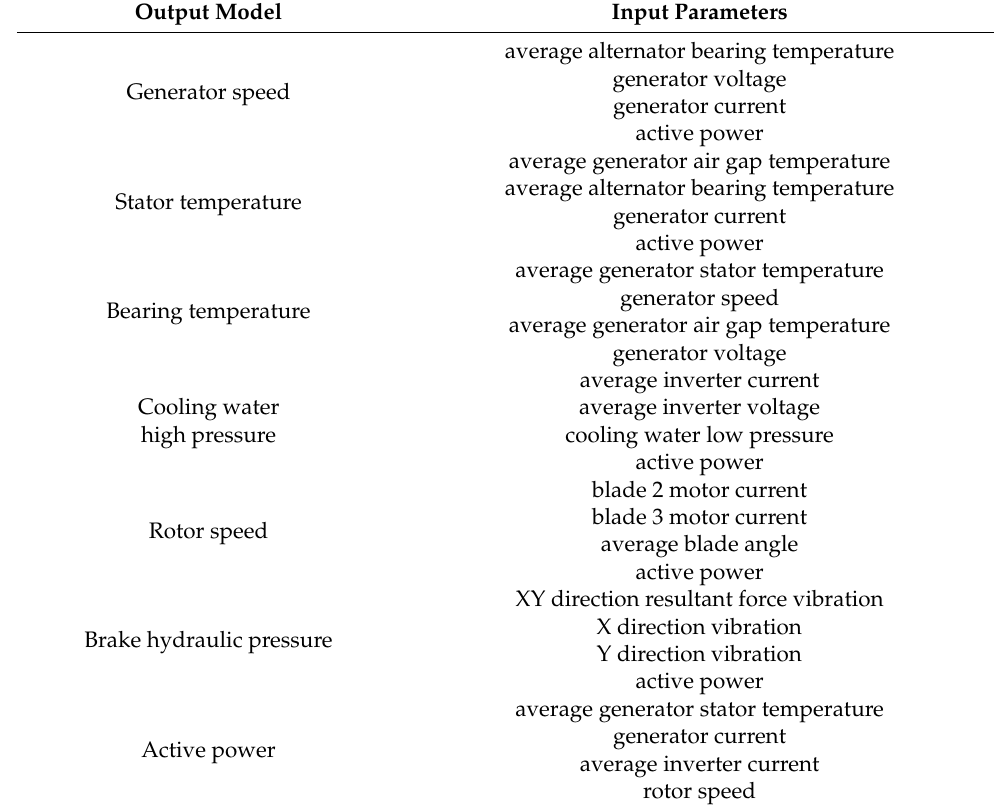
Table 3. List of input parameters for each output